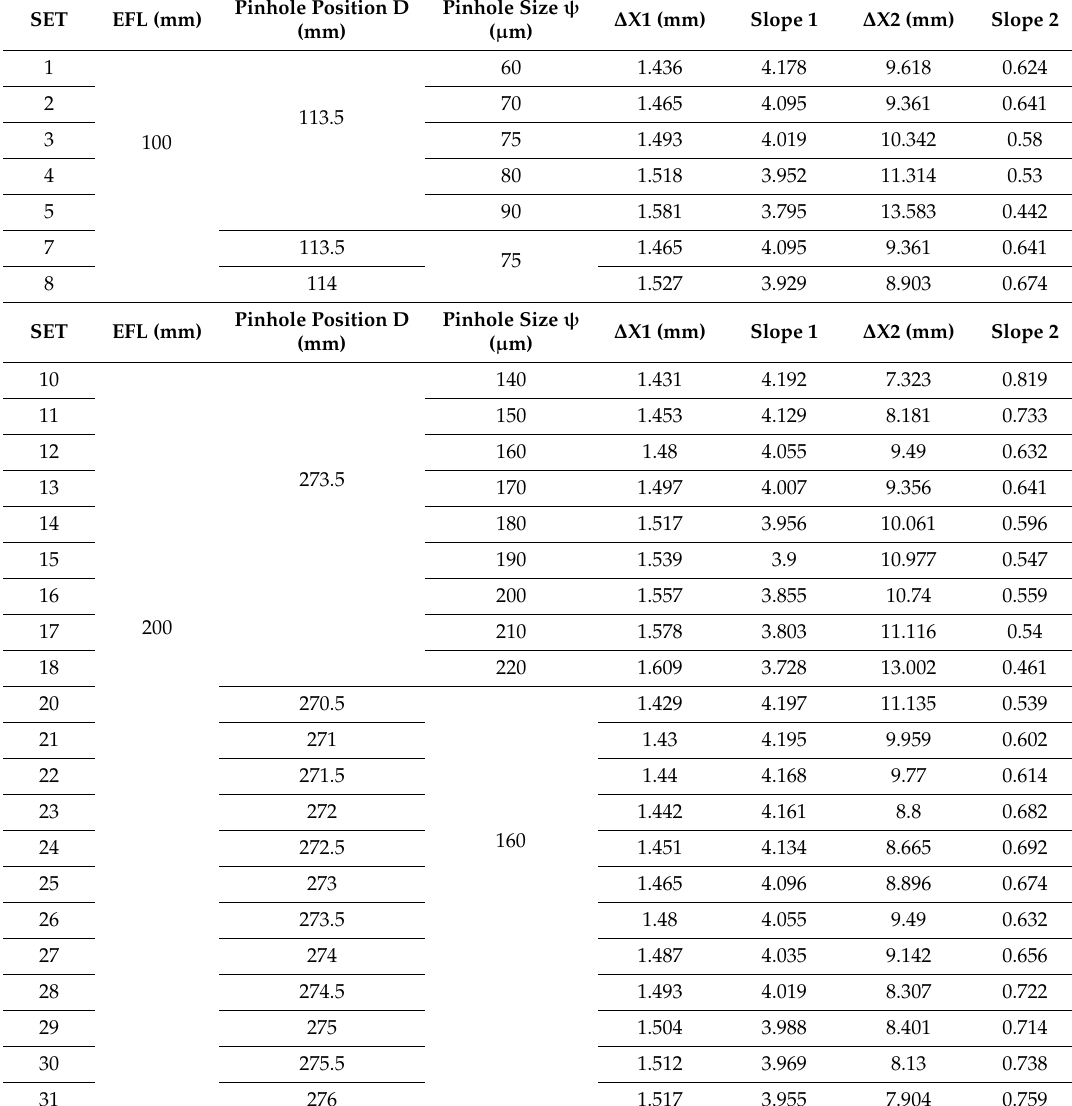
Table 3. Our simulation of the optimal parameters for the rear focal point.